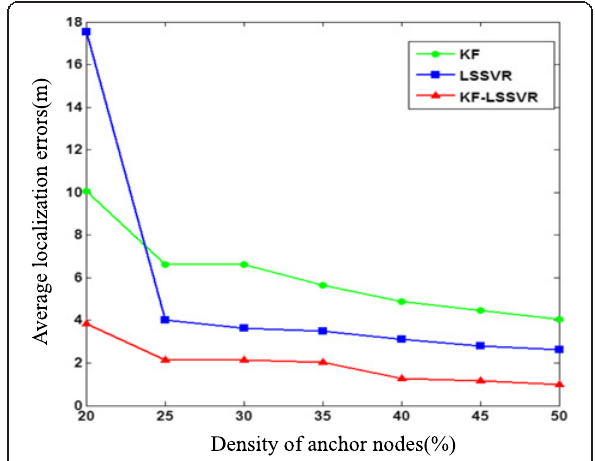
Fig. 3 Relationship between average localization errors and anchor node density